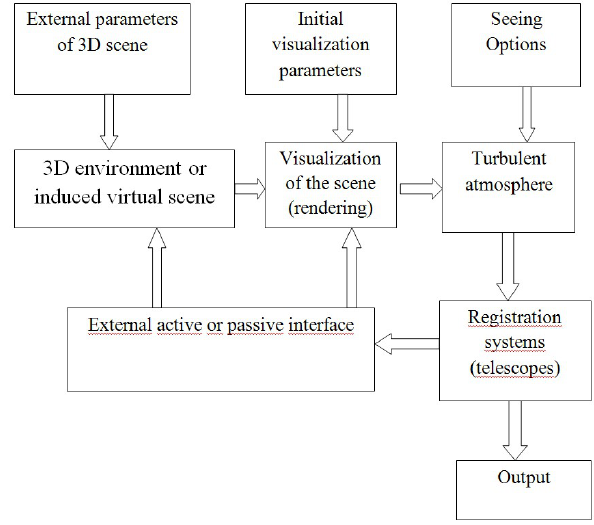
Figure 3. Induced virtual environment technique